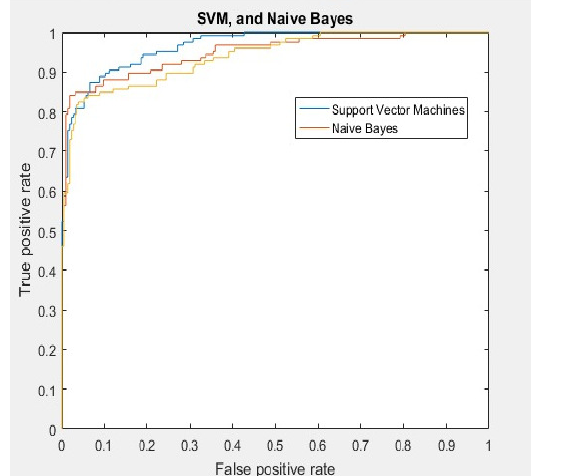
Fig. 19: Comparison of SVM and Naïve